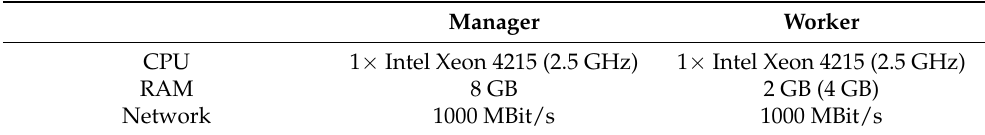
Table 5. Configuration of the computing nodes.